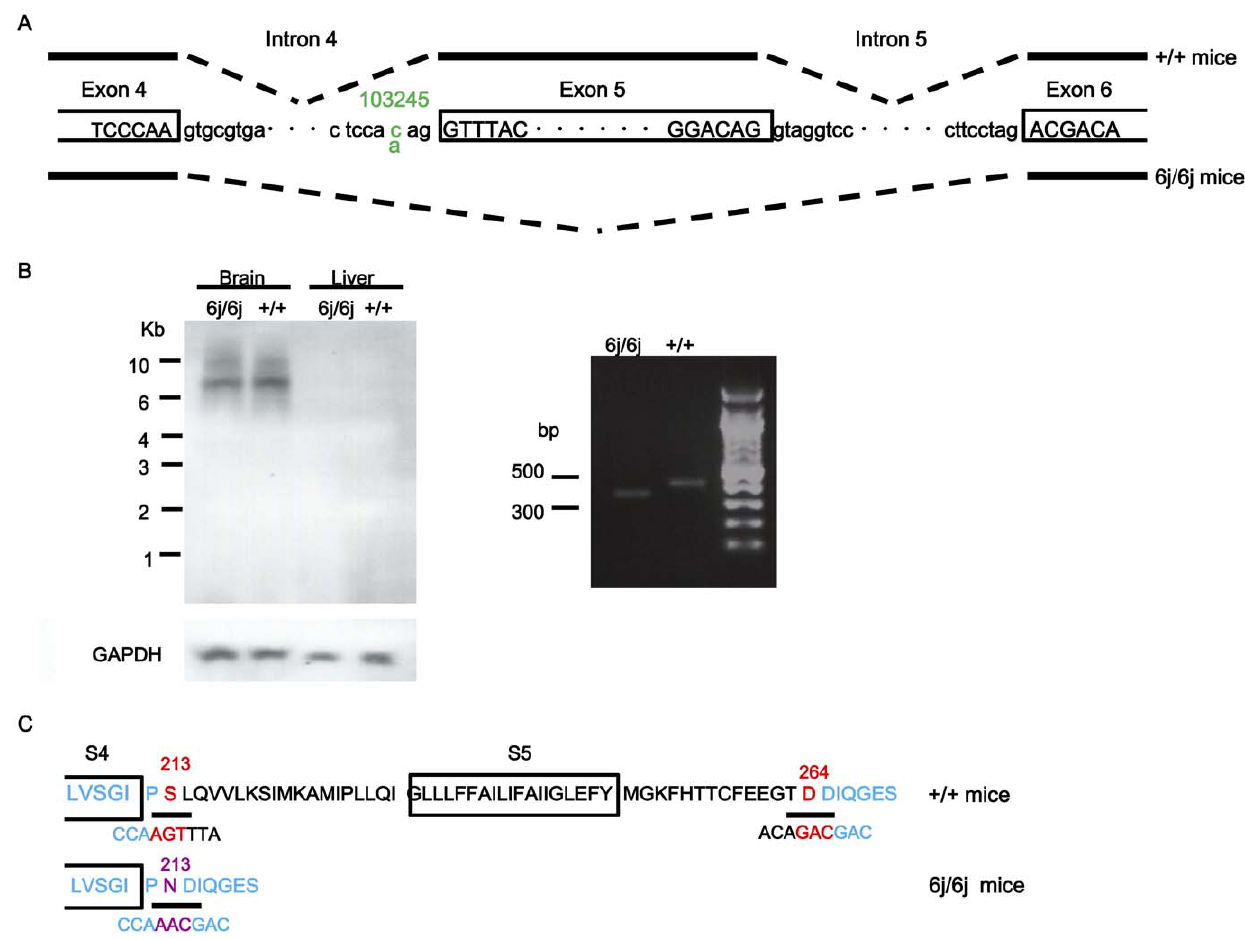
Figure 1. Structure and expression of the Cacna1a gene in tottering-6j mice. Intron/exon and transcript structure in 6j / 6j and + / + strains is shown (A). Exon sequences are indicated by capital letters in boxes. Intron sequences indicate lowercase. The C-to-A substitution at the nucleotide residue 103245 is indicated in green. Transcripts are indicated below and above as genotypes; these are 6j / 6j and + / + strain, respectively. Splicing events are indicated by dashed lines. Analysis of Cacna1a gene expression in 6j / 6j ( n= 8) and + / + ( n= 8) mice by Western blot and RT-PCR (B). Representative protein expression pattern of the Cacna1a gene is shown. GAPDH was used to control for total RNA loading. No differences were observed between the 6j / 6j and the + / + mice. Representative RT-PCR results are shown. The fragment from the brain of the 6j / 6j mice was smaller compared with that of the + / + mice. A part of protein sequences of domain I in the Ca v 2.1 a 1 are shown (C). The protein sequence for the transmembrane segments of S4 and S5 is indicated by the boxes. The upper protein sequence is + / + and the lower is 6j / 6j , respectively. The nucleotide sequence encoding the amino acid is indicated under the protein sequence. The blue highlighting indicates the alternate exons. Red highlighting indicates amino acids encoded across a splice junction. The deleted amino acid region is 213–264. The altered amino acid is 213 is indicated in purple.